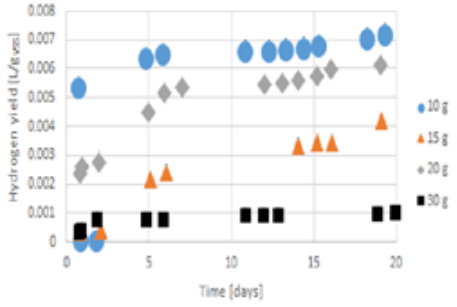
Figure 6. Accumulated hydrogen production from gelatine in the first 20 days for gelatine concen- trations from 10 g VSS/L to 30 g VSS/L.